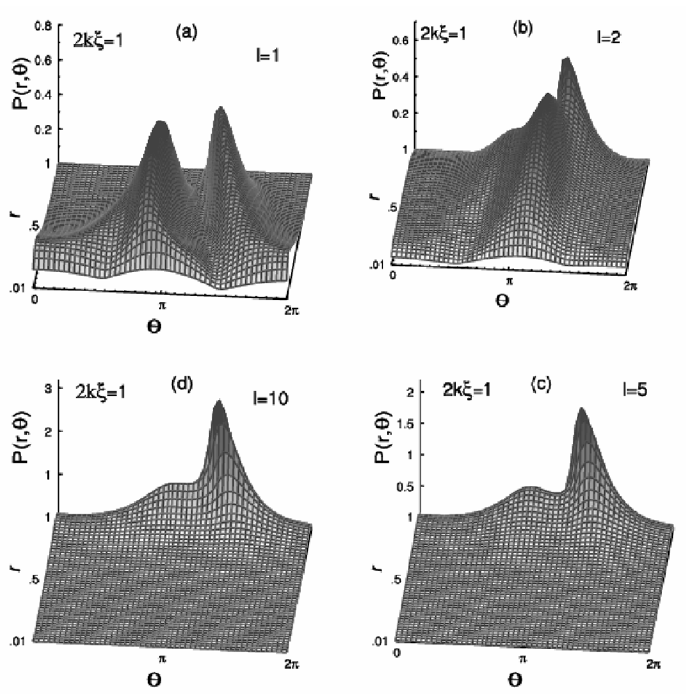
Figure 2. Evolution of the probability P ( r , θ ) with the sample length l (= L / ξ ) in the weak disorder regime for a fixed disorder strength parameter 2 k ξ = 100. Plots are for sample lengths: ( a ) l = 1, ( b ) l = 2, ( c ) l = 5, and ( d ) l = 10.